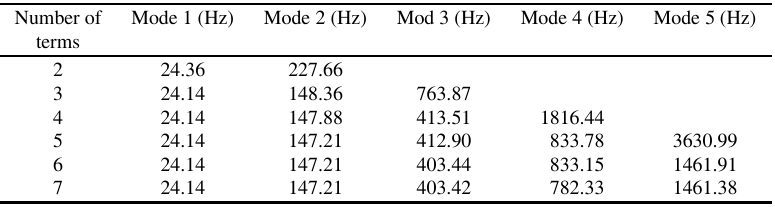
Table 4 Convergence of natural frequencies as a function of number of terms in the polynomial shape